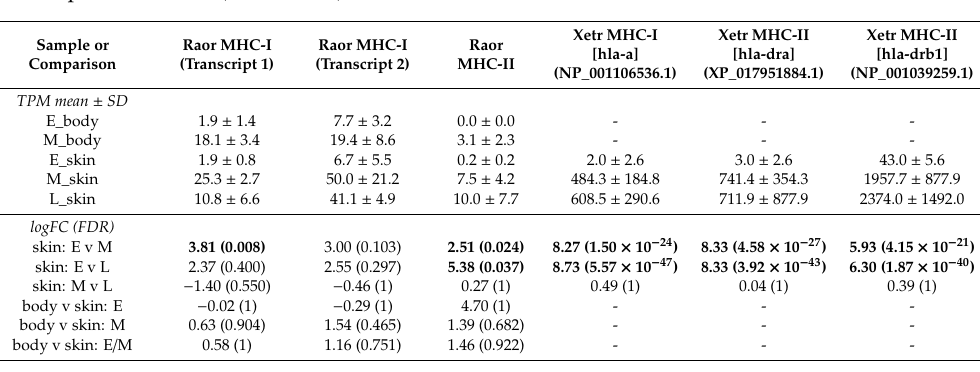
Table 2. Normalized expression of MHC class I and II transcripts between di ff erent larval stages (E—early, M—mid and L—late, see Table S1) or tissues of Rana ornativentris (Raor) and Xenopus tropicalis (Xetr), represented by TPM (transcripts per million) values, and logFC and false discovery rate (FDR) values of pairwise comparisons between samples. Transcripts with significantly di ff erent normalized MHC expression levels (FDR < 0.05) are indicated in